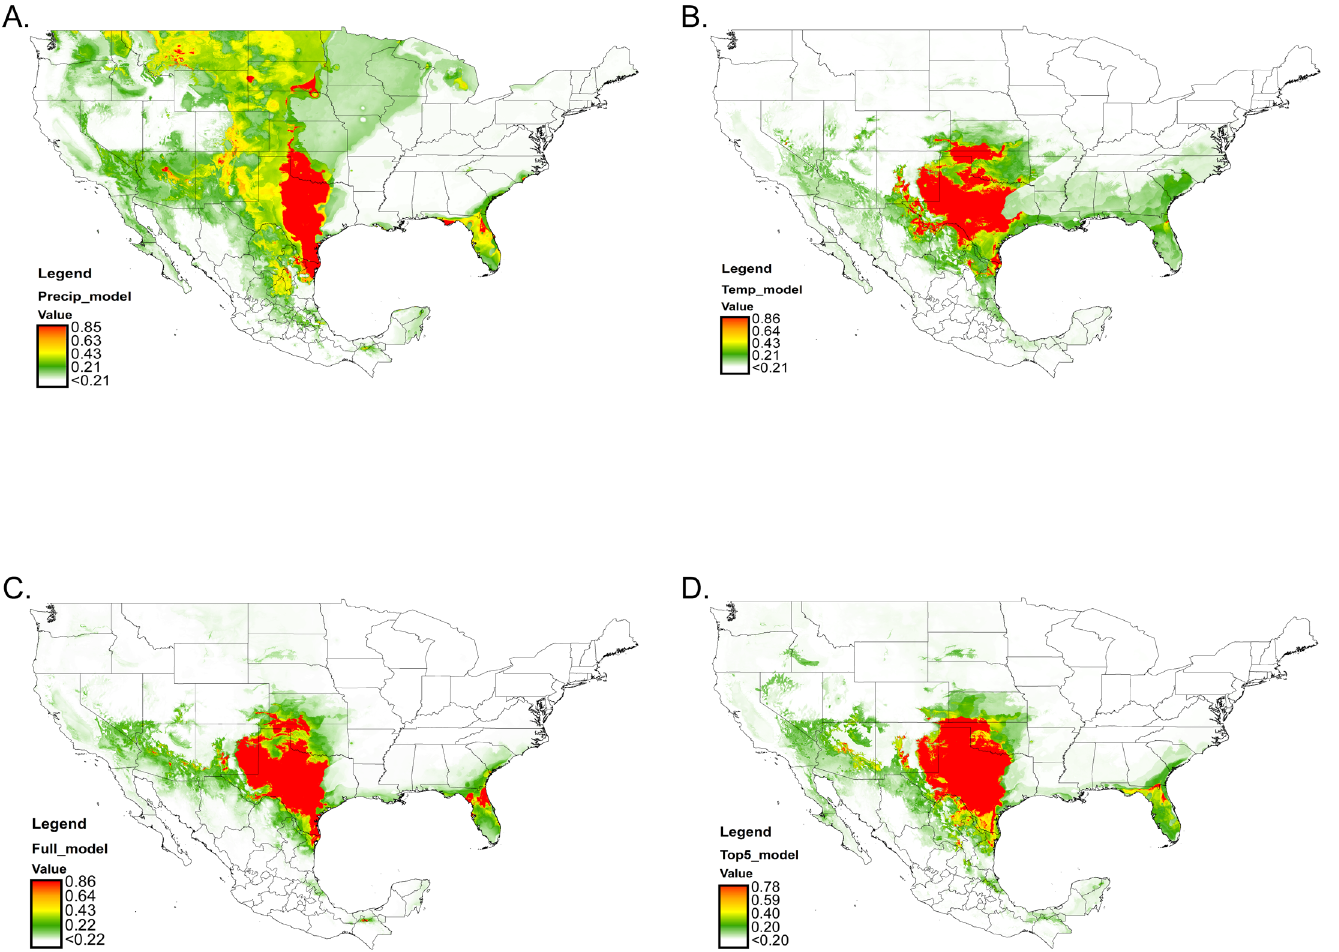
Fig 2. Model predictions for the distribution of O . turicata based on current climate conditions: A) precipitation model, B) temperature model, C) full model, and D) top-five environmental variables model. Probability of O . turicata classified into 5 categories: very high probability (red), high probability (orange), moderate probability (yellow), low probability (green), and very low probability (white).